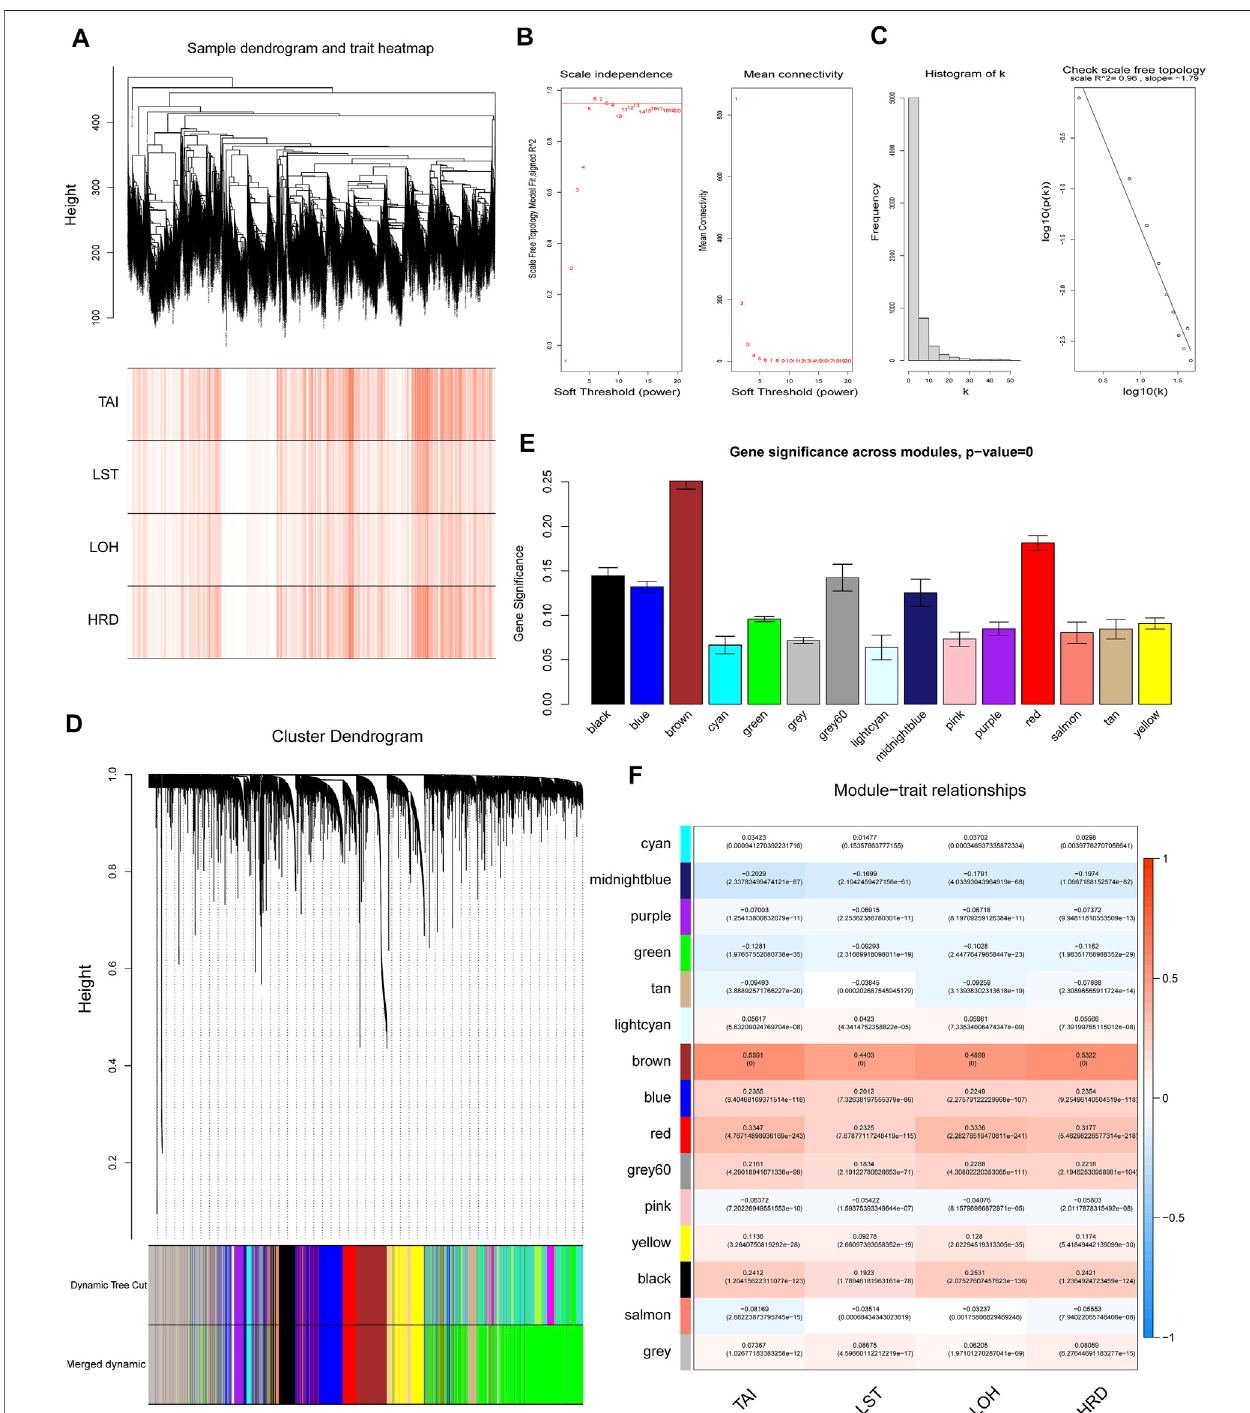
FIGURE2| Weightedgeneco-expressionnetworkanalysis. (A) Thesampledendrogramand traitheatmapof6,386genes. (B) Analysisofscale-free topologyfor varioussoft-thresholdpowers( β ),includingthescale-free fi tindexandmeanconnectivity. (C) Scale-freenetwork(scale-free R 2 (cid:1) 0.96,slop (cid:1) − 1.79). (D) Dendrogramfor the intersection of differentially expressed genes, clustered based on a dissimilarity measure, together with assigned module colors. (E) Gene signi fi cance across modules. (F) Analysis of module – trait relationships of endometriosis. Each row represents a module eigengene. Each column represents a trait. Groups indicate telomeric allelic imbalance (TAI), large-scale state transitions (LSTs), loss of heterozygosity (LOH), and HRD combined score.